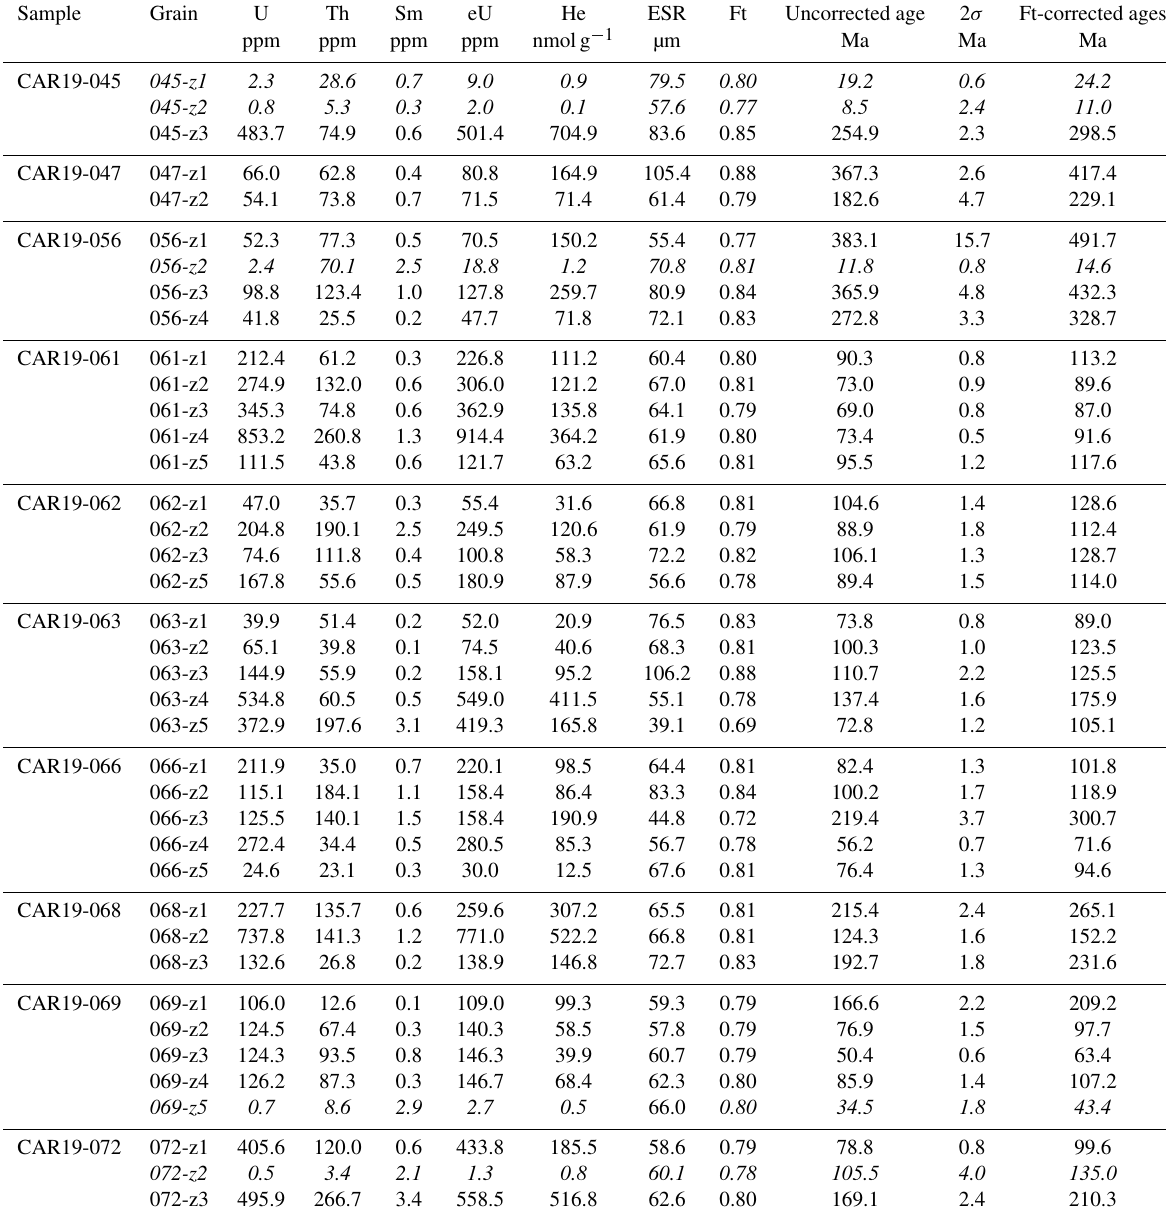
Table 4. Zircon (U–Th–Sm) / He data. Ages in italics are considered outliers and were not used in the models or for interpretations. eU: equivalent uranium content; ESR: equivalent spherical radius; 2 σ : weighted 2 σ analytical uncertainty from analysis of age standards.